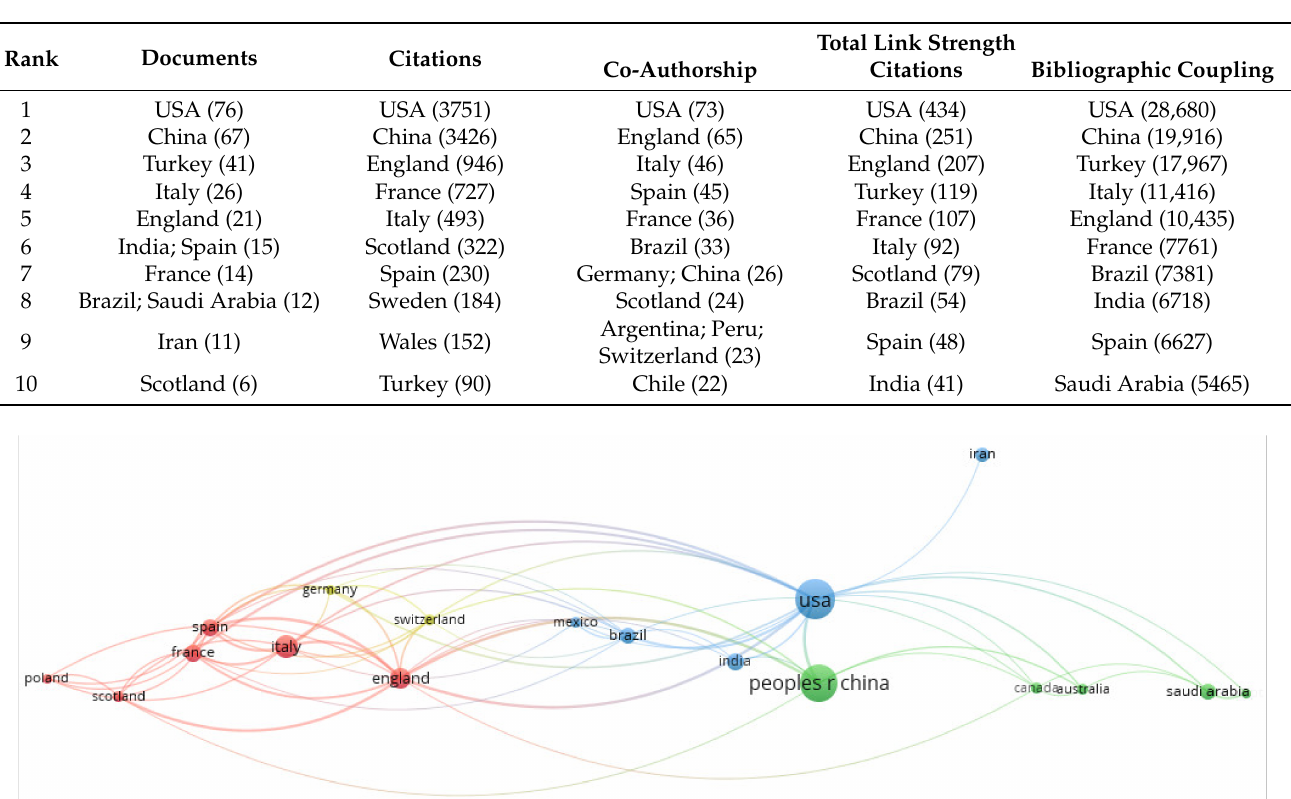
Table 1. Statistics by countries.